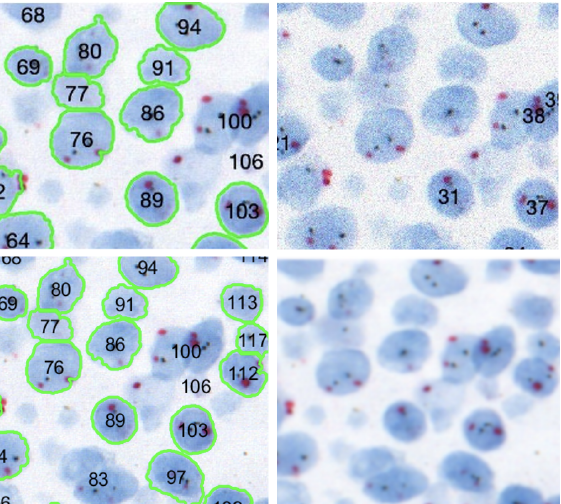
Figure 4. The nuclei detection method succeeded for the original ( top-left and bottom-left ) images but failed for the blurry ( bottom-right ) and noisy version of the images ( top-right ).